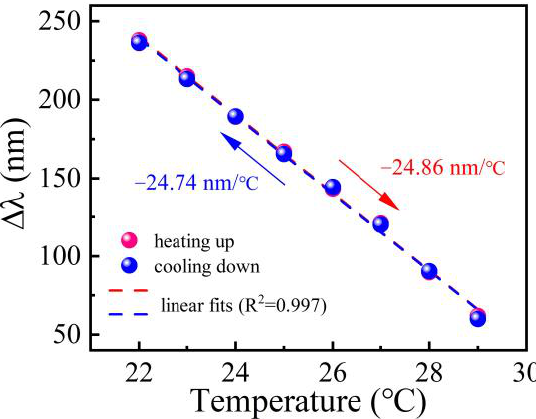
Figure 8. Differential wavelength (i.e., λ L −λ S ) as a function of the temperature in the case of temperature cycling from 22 to 29 °C.